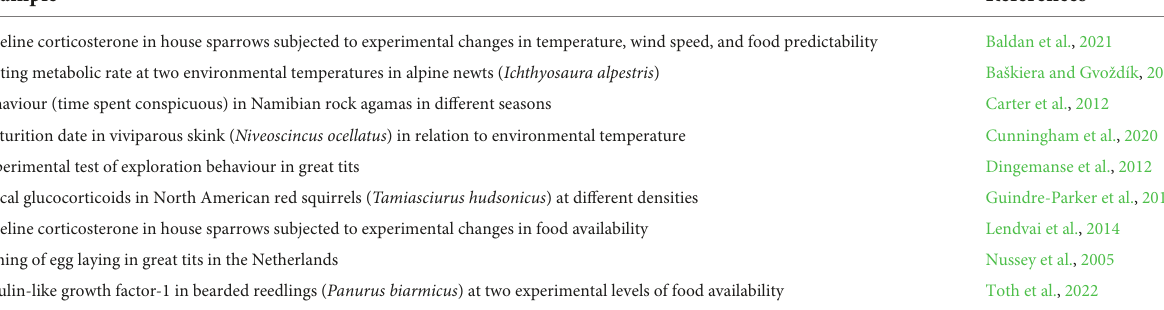
TABLE 5 Examples of reaction norm studies that showed individual variation in slopes (individual variation in